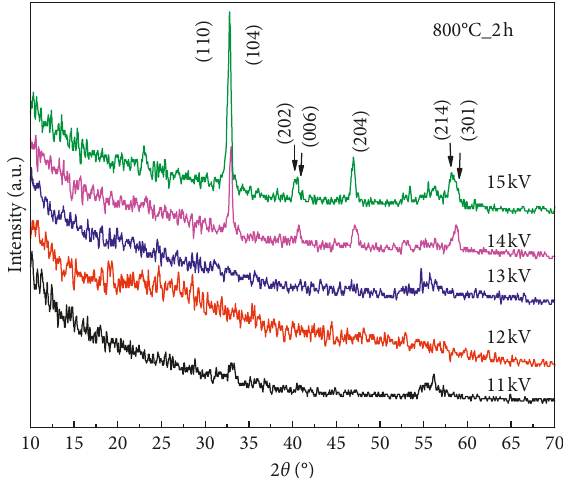
Figure 7: XRD patterns of LaMnO 3 thin films deposited at 11, 12, 13, 14, and 15kV after annealing at 800 ° C for